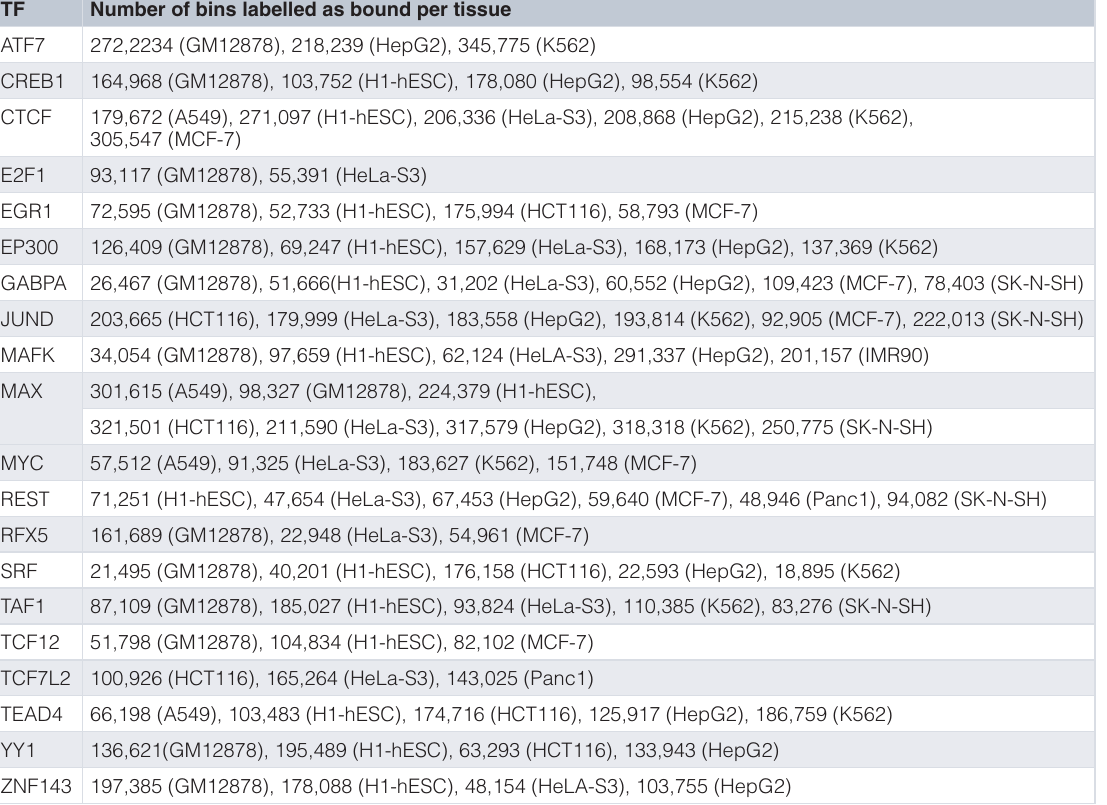
Table 1. Number of bins labeled as bound per transcription factor (TF) and tissue, deduced from TF ChIP-seq data. TF Number of bins labelled as bound per tissue